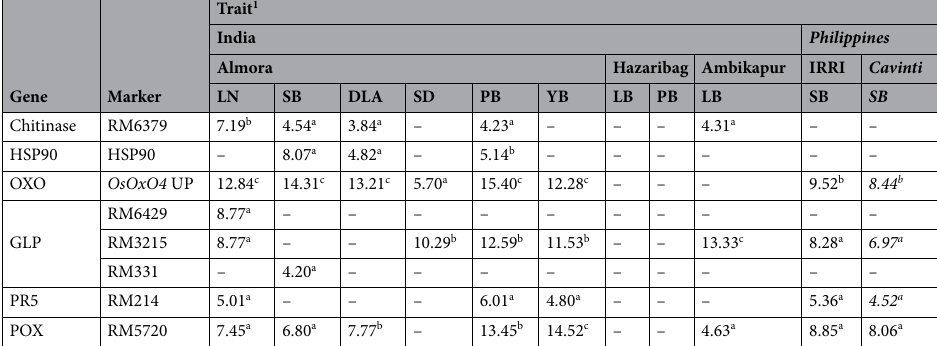
Table 2. Phenotypic contribution (percentages) of candidate gene allele to rice blast disease resistance in Vandana, Moroberekan and intermated F 6 lines screened for resistance to rice blast at multi-location trials in India and the Philippines. LN lesion number, SB seedling blast, DLA diseased leaf area, SD start of disease (days after sowing), PB panicle blast, YB yield under blast condition, LB leaf blast. 1 Significance level of correlation is: a p < 0.05; b p < 0.01; c p < 0.001; (–) not